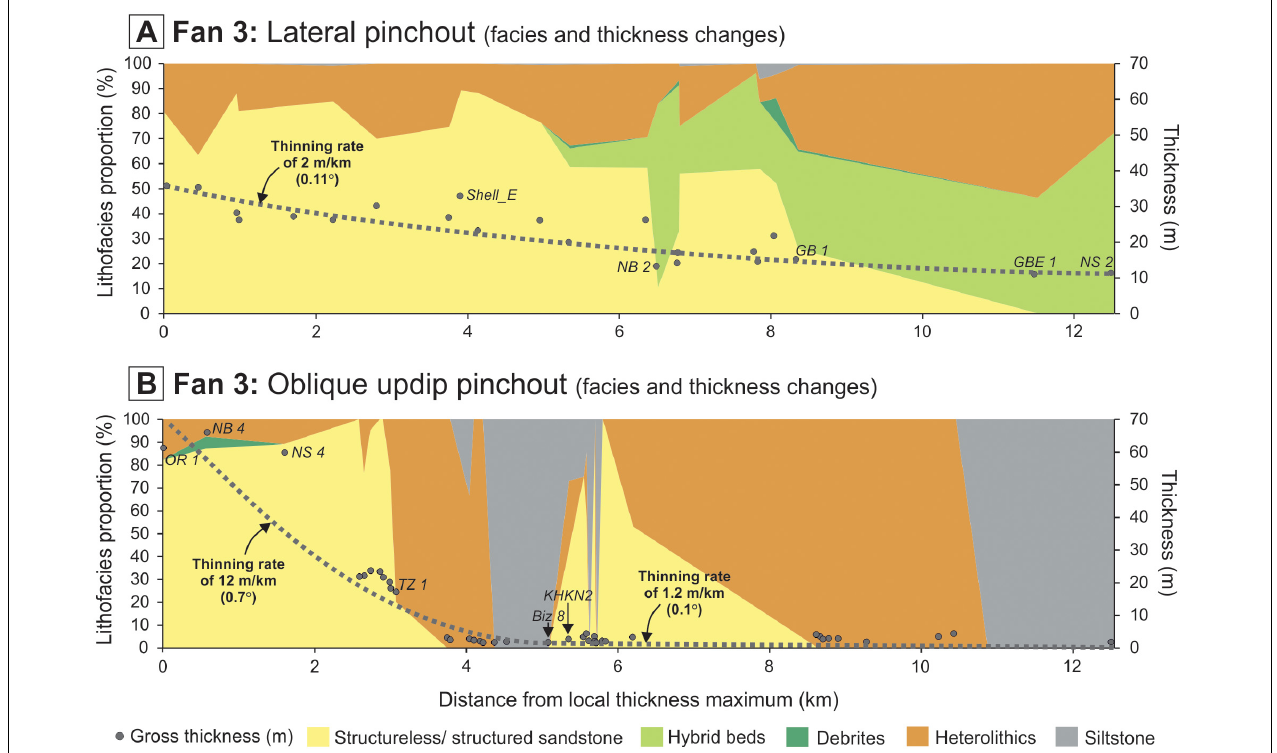
FIGURE 7 | (A) Facies and thickness changes of the lateral pinchout of Fan 3 (location shown in Figure 2 ) showing a gradual decrease in thickness toward the lateral pinchout of Fan 3 and a decrease in sandstone content while the percentage of hybrid beds increases. (B) Facies and thickness changes of the oblique up-dip pinchout of Fan 3 (location shown in Figure 2 ) showing an abrupt decrease in Fan 3 thickness and sandstone content. Percentage sandstone increases again at 6 km from the local maximum fan thickness. Note that the thickness and facies proportions were calculated only over the correlative stratigraphic interval and the trendlines are only indicative of the overall trend and not mathematically